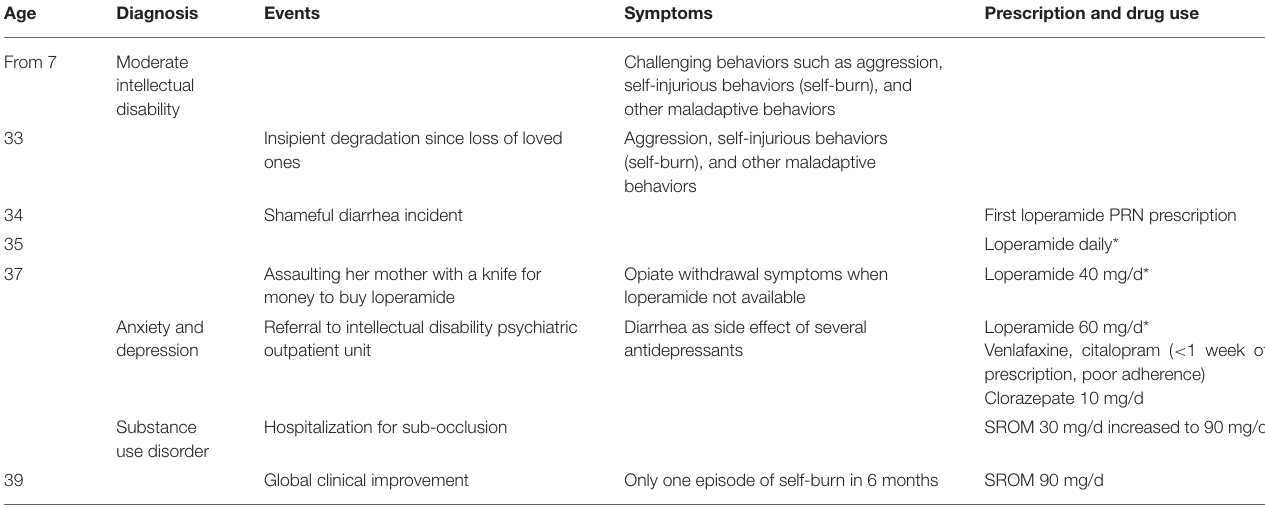
TABLE 1 | Timeline of patient’s main diagnosis, events, symptoms and